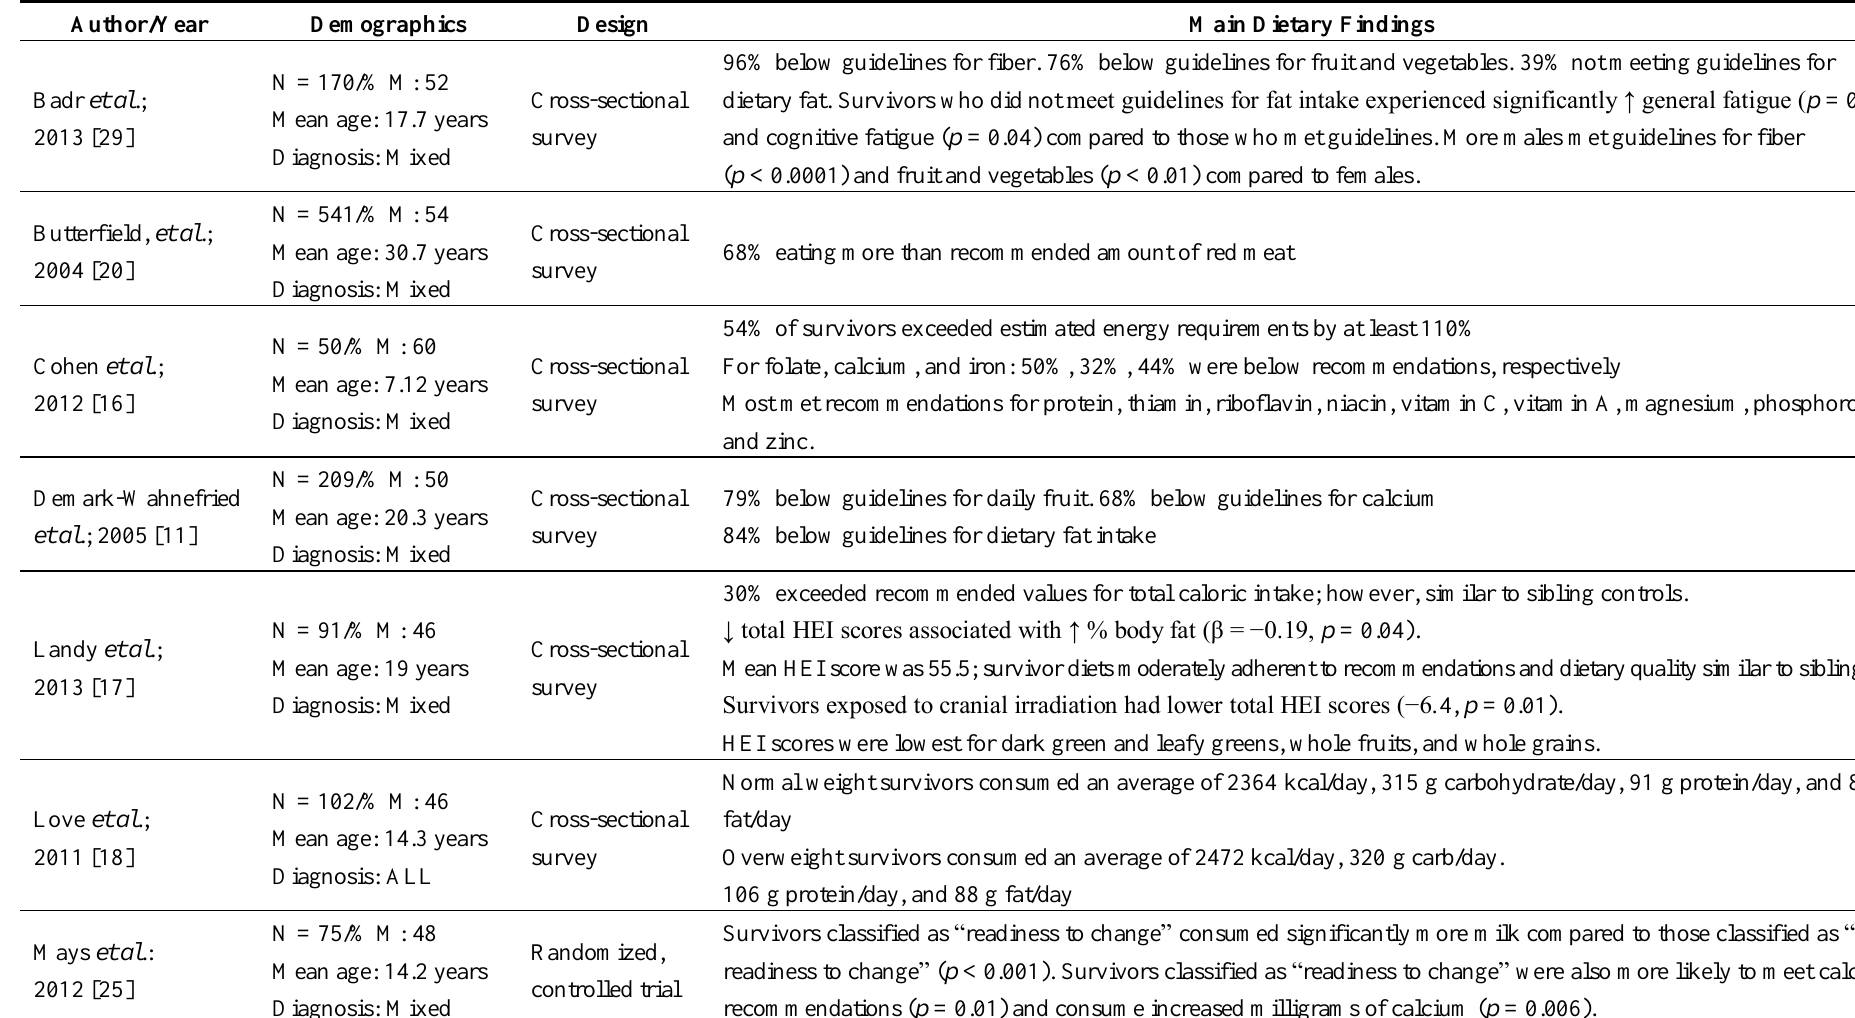
Table 1. Summary of select studies reporting on dietary intake in survivors of childhood